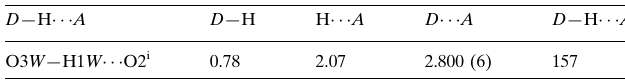
Hydrogen-bond geometry (A˚ , (cid:2)